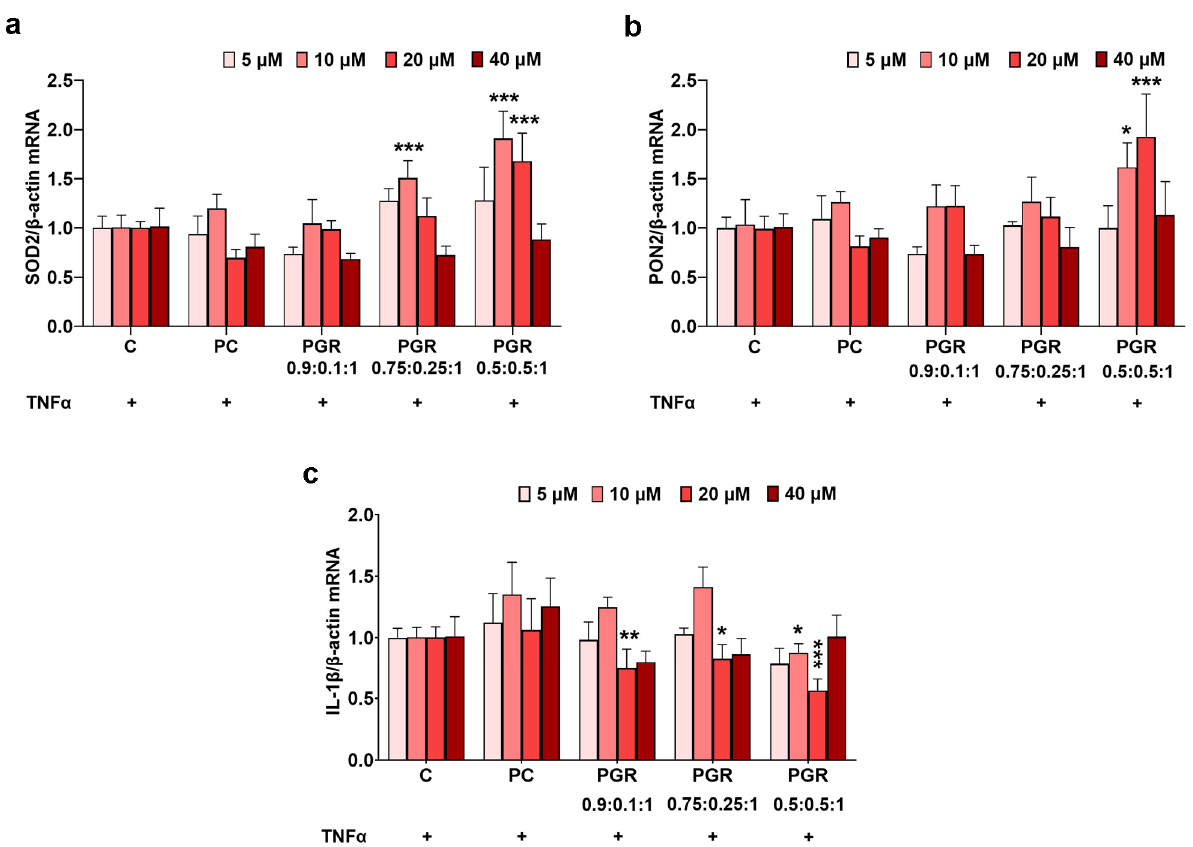
Figure 4. The antioxidant and anti-inflammatory effects of PHYTOGINROSA (PGR) with different mass ratios of GINex:ROSAex:FC (0.9:0.1:1, 0.75:0.25:1 and 0.5:0.5:1) and at different concentrations of 6-gingerol equivalent (5, 10, 20 and 40 µM) in Caco-2 enterocytes activated with TNF α . The gene expression for superoxide dismutase 2 (SOD2) ( a ), paraoxonase 2 (PON2) ( b ) and interleukin 1 β (IL-1 β ) ( c ) are represented relative to that of TNF α -exposed cells. The results are presented as means ± SD. * p < 0.05, ** p < 0.01, *** p < 0.001 for TNF α +PGR vs. TNF α